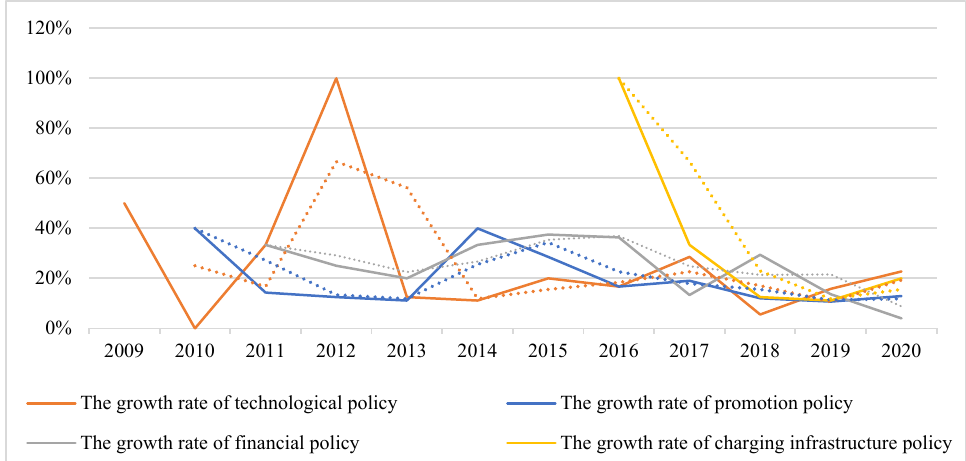
Figure 5. The differences in the growth rate of policy. The comparison matrix of policy intensity is 𝐻 = shown in Figure 6, the policy intensity of the charging infrastructure policy was weakest. The policy intensity of the promotion policy ranked first, followed by technical policy,